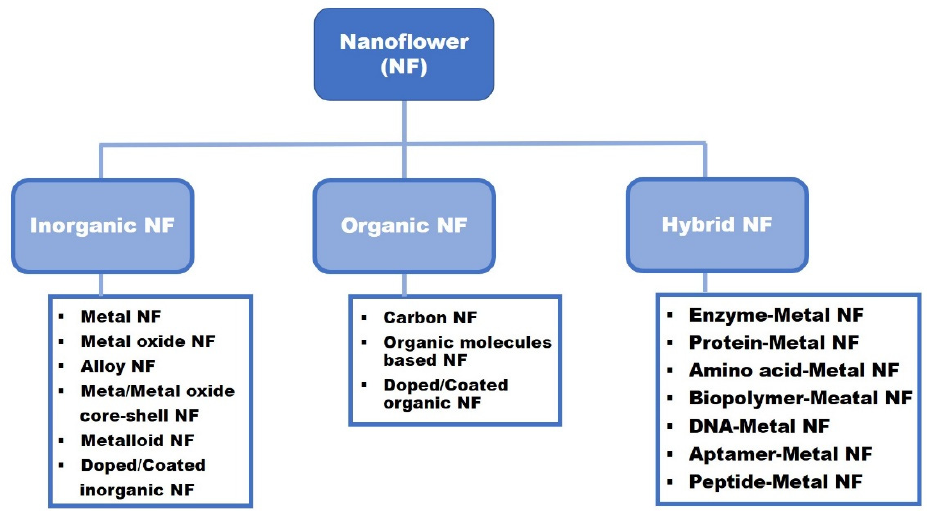
Figure 1. Nanoflower classification schematic according to the